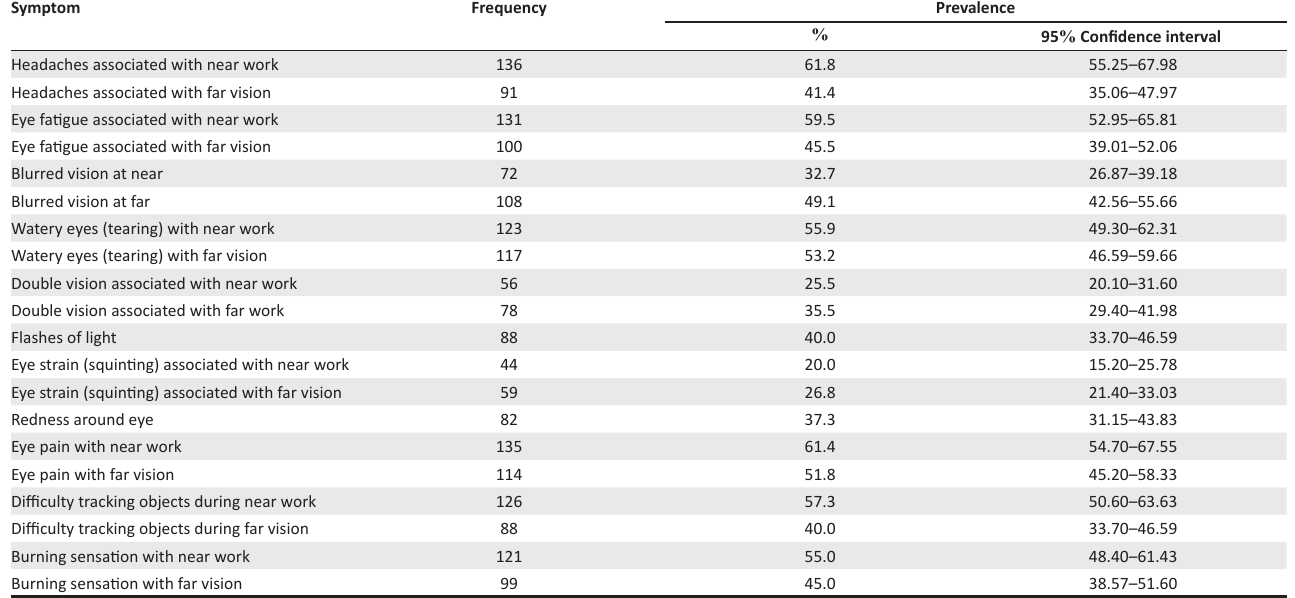
TABLE 1: Distribution and prevalence of specific asthenopic symptoms among participants with severe or very severe asthenopic symptom. Symptom